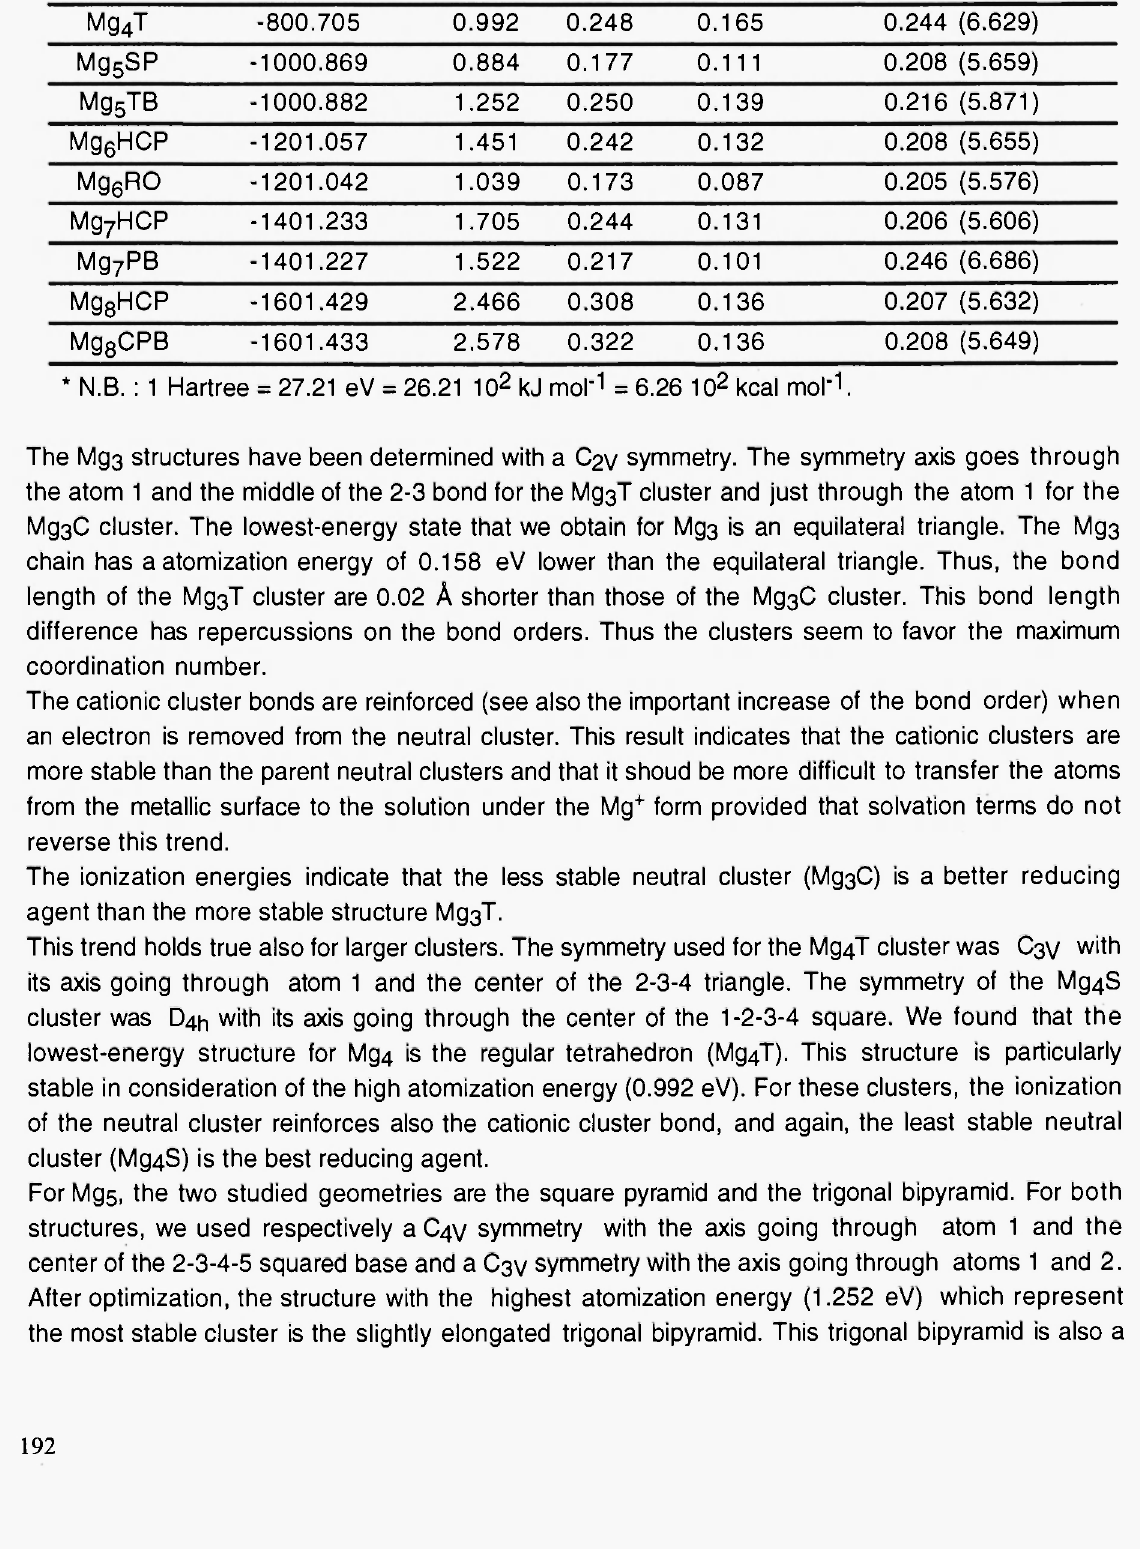
Figure 3 : Total, atomization, relative atomization and ionization energies for Mg n . Cluster Total energy